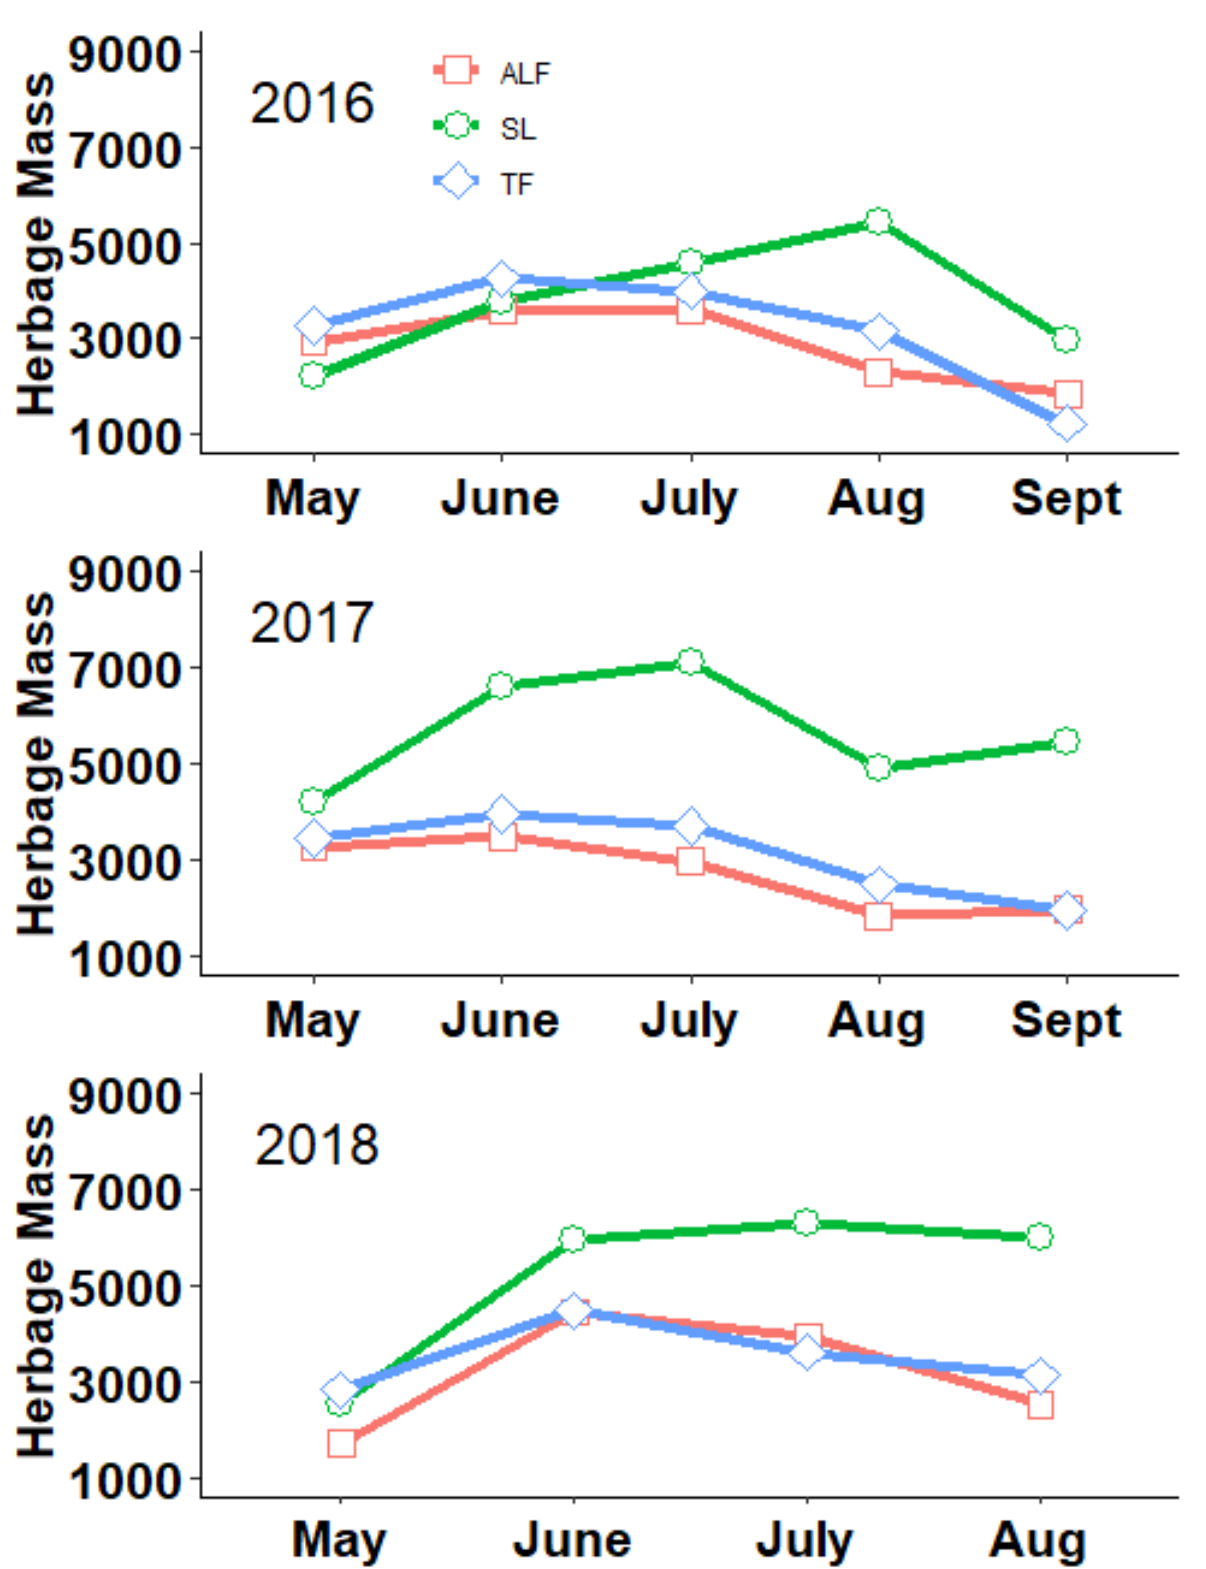
Figure 1. Mean monthly herbage mass (kg ha − 1 ) over each grazing season, 2016–2018. ALF—tall fescue with alfalfa monoculture, SL—tall fescue with sericea monoculture, and TF—tall fescue control. Herbage mass samples were not collected in September 2018.